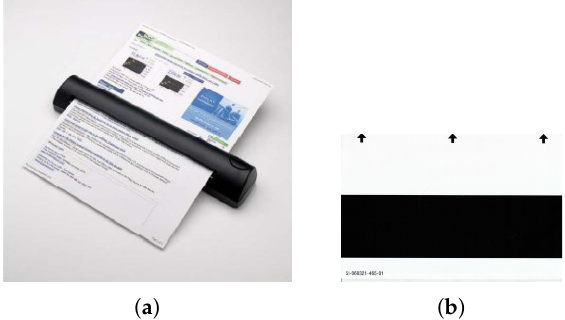
Figure 7. An automatic feed portable document scanner can be converted into a multi-spectral document scanner: ( a ) the DSmobile600 sheet-feed portable document scanner from Brother Mobile Solutions Inc. , Westminister, CO, USA used in this work; and ( b ) a standard black and white reference sheet for calibration. Arrows indicate the direction of feeding into the scanner.